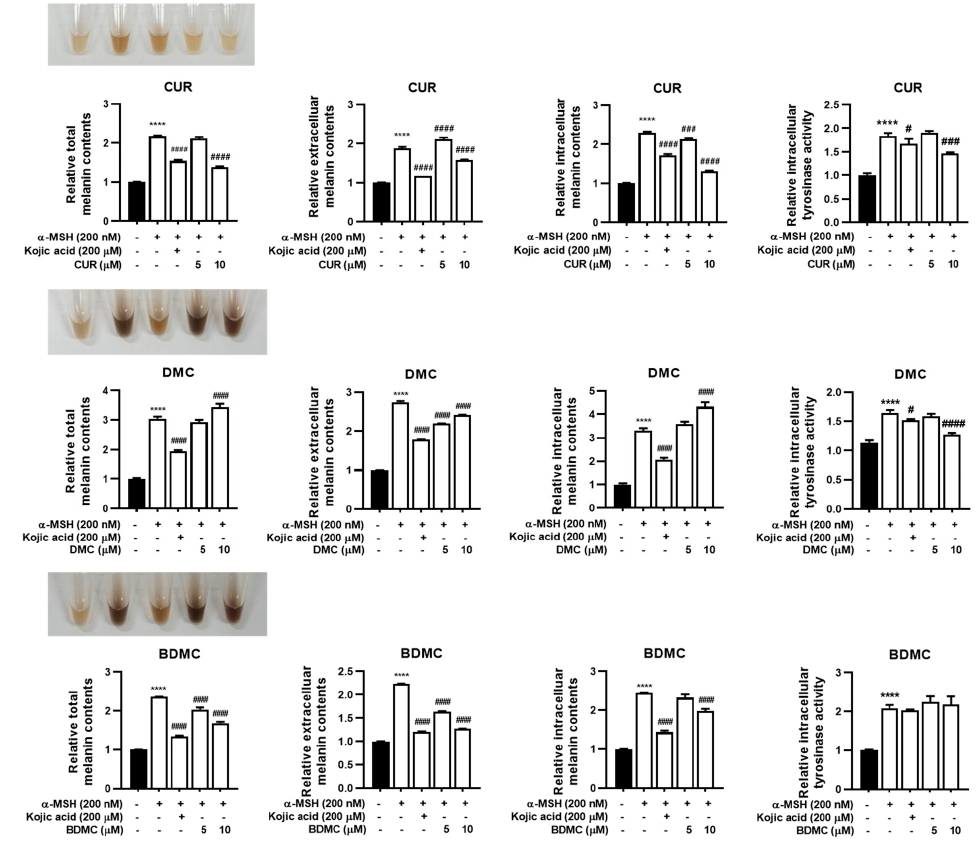
Figure 2. Inhibitory effect of curcumin (CUR), dimethoxycurcumin (DMC), and bisdemethoxycurcumin (BDMC) on alpha-melanocyte stimulating hormone ( α -MSH) inducing melanogenesis in B16F10 mouse melanoma cells. The color changes of phenol-free media by accumulation of melanin at 48 h and determined intracellular, extracellular, total melanin contents, and tyrosinase activity after treatment of stimuli ( α -MSH), positive control (kojic acid), CUR, DMC, and BDMC, respectively. Data are presented as mean ± standard deviation (SD). Significant differences are expressed by the symbols ****, #, ###, and #### as **** p < 0.0001 compared with control and # p < 0.05, ### p < 0.001, and #### p < 0.0001 compared with the α -MSH-treated group, respectively.